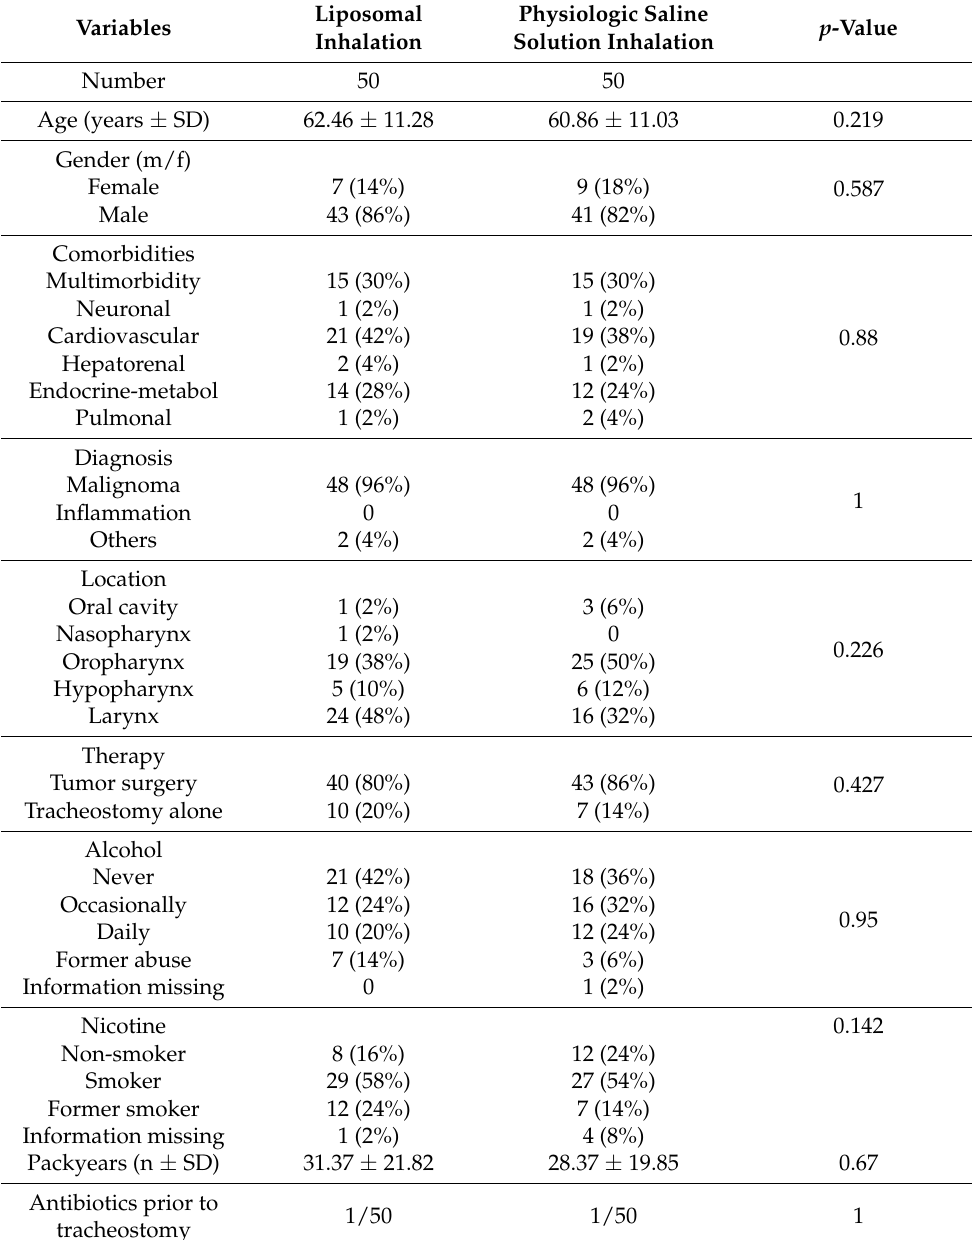
Table 1. Comparison of baseline demographic and clinical characteristics of included and randomized